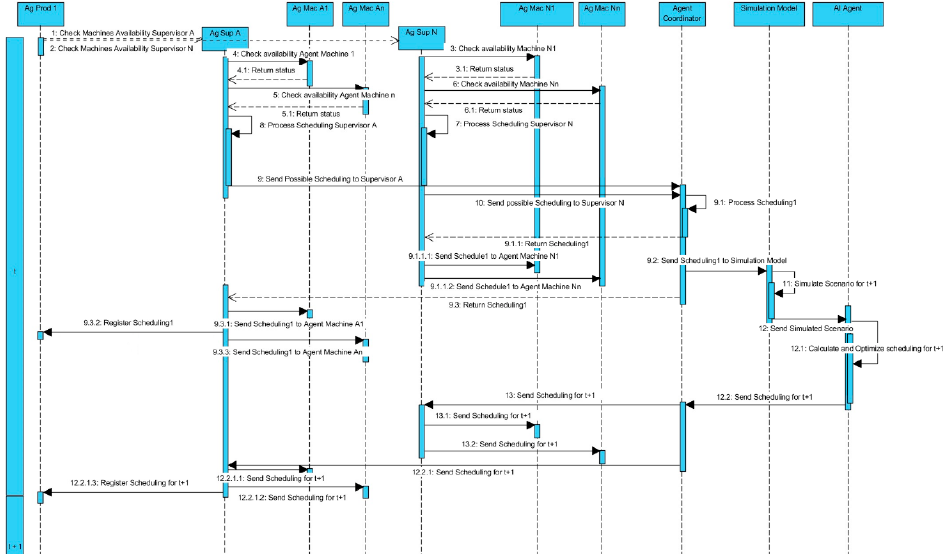
Figure 4. UML sequence diagram of the data exchange between agents.